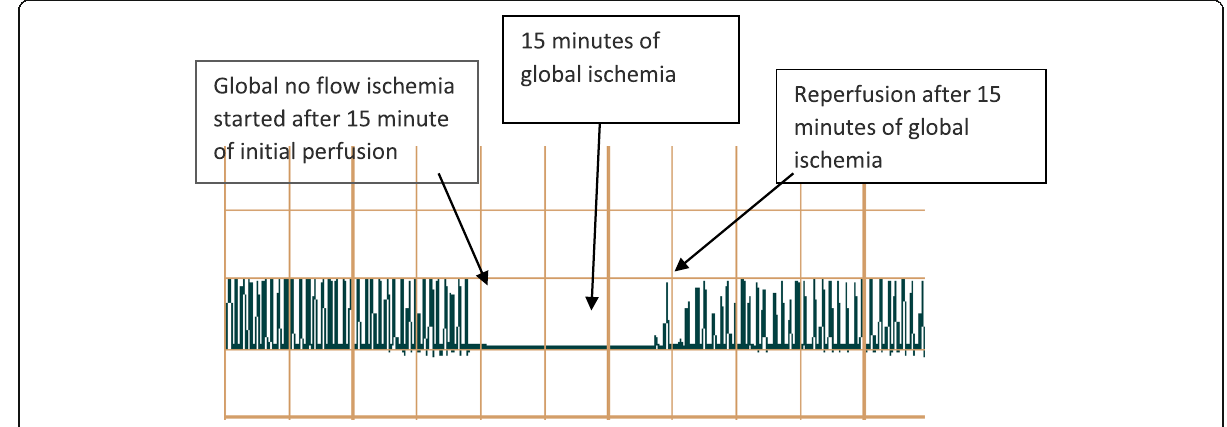
Fig. 9 Tracing on Polygraph of